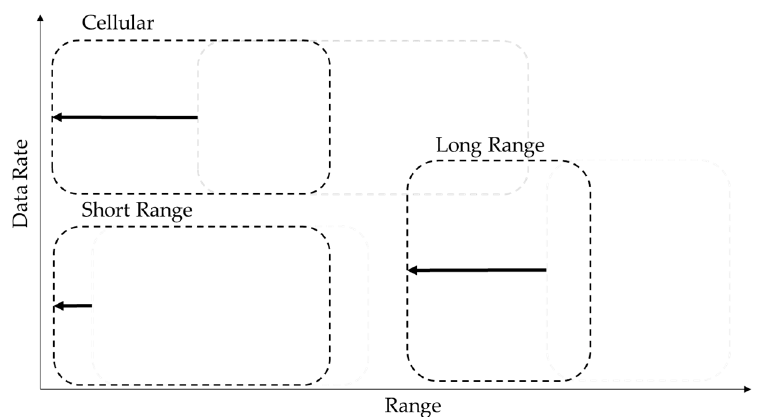
Figure 5. Data rate vs. (underground) range of radio: Shifted Technology Clusters due to harsh underground conditions. The further a signal must travel and propagate, the more it is influenced by the conditions and dependant on its signal propagation properties.